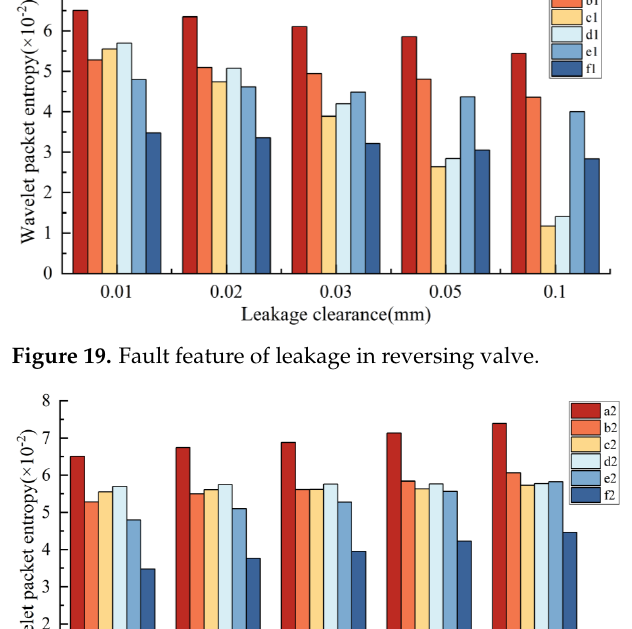
Figure 19. Fault feature of leakage in reversing valve.